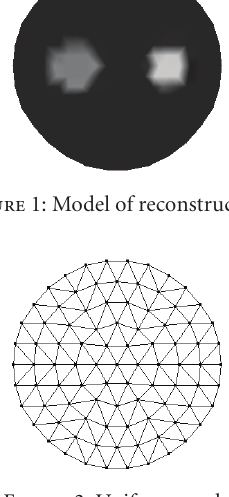
Figure 2: Uniform